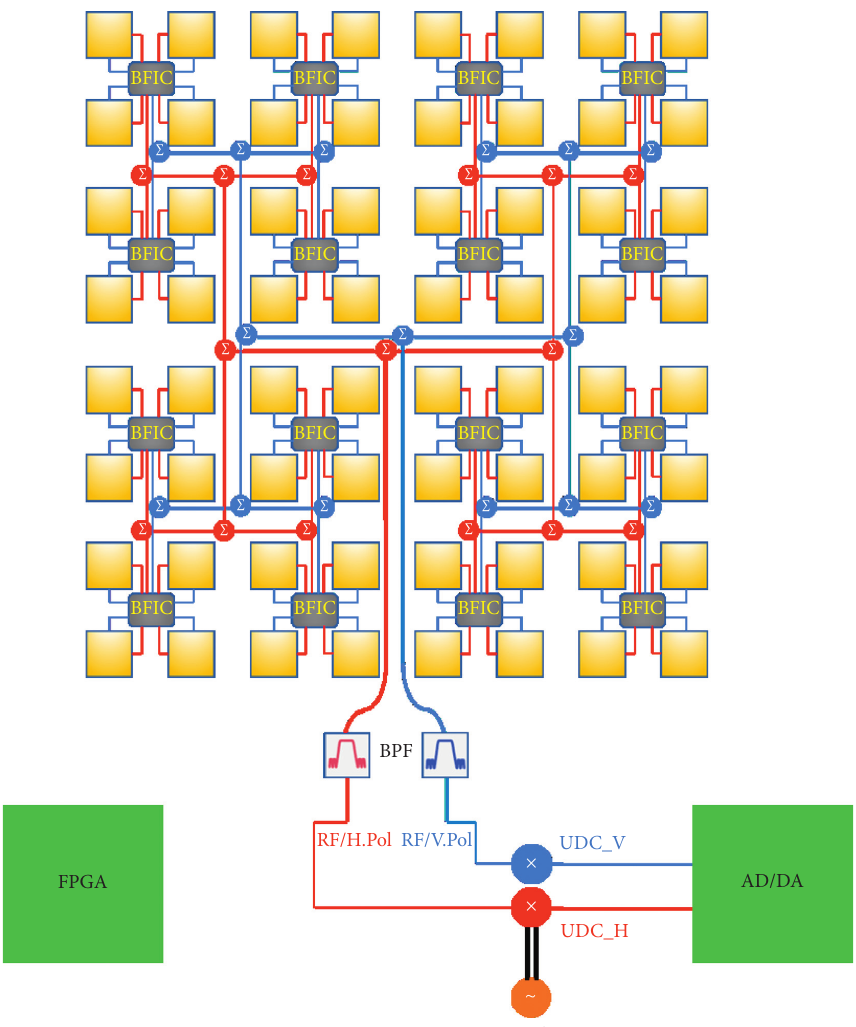
Figure 14: Diagram of a 5G phased array antenna capable of dual-beam operation and comprising 64 dual-polarized radiating elements, this resulting in 2 × 64 array inputs. Every beamforming integrated circuit (BFIC) is connected to 8 antenna inputs/outputs (with each dual- polarized antenna having two inputs/outputs) and has two common inputs/outputs (one per polarization as indicated with the blue and red color lines) connected to polarization-specific Wilkinson’s